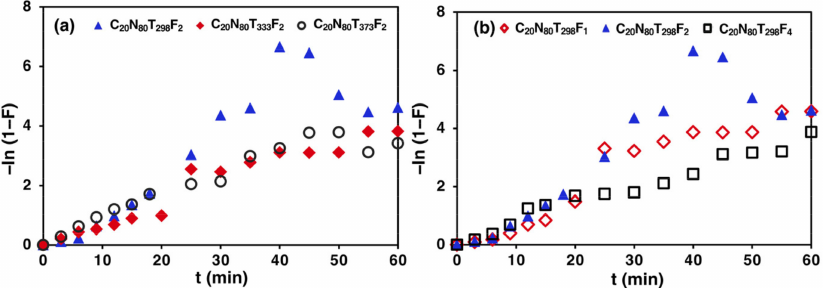
Figure 8. Boyd model plots of CO 2 adsorption on zeolite 5A at ( a ) different temperatures; ( b ) different feed flow rates.